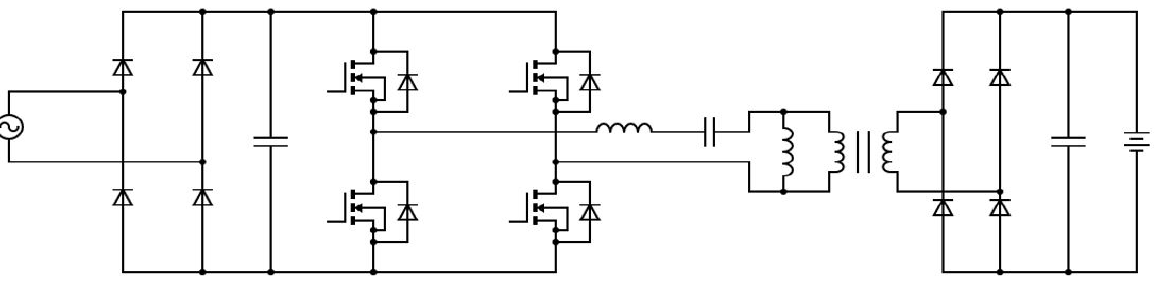
Figure 11. Full bridge LLC converter [22].